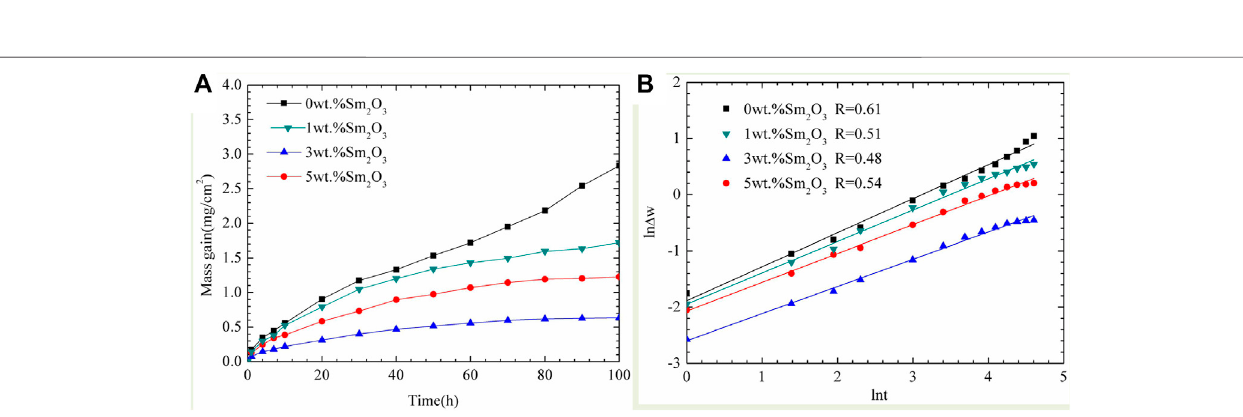
FIGURE 5 | XRD patterns of the as-deposited (A) NiCoCrAlY coating and (B) NiCoCrAlY- x Sm 2 O 3 coatings.